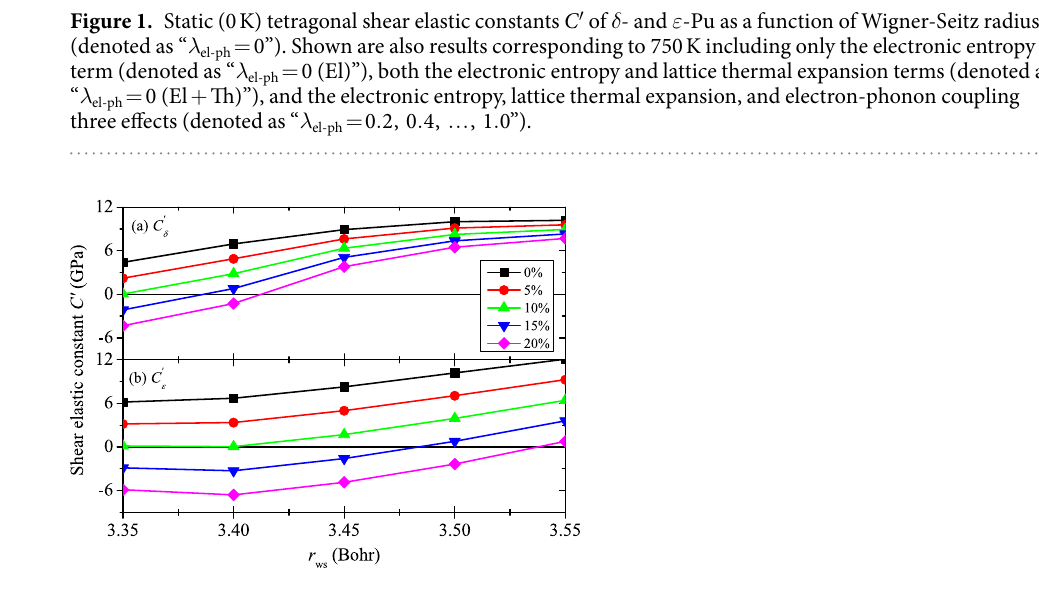
Figure 2. Tetragonal shear elastic constants C ′ of δ - and ε -Pu as a function of Wigner-Seitz radius. Results correspond to 750 K, including the electronic entropy, lattice thermal expansion, electron-phonon coupling ( λ el-ph = 1.0), and spin fluctuation effects modelled by reducing μ Pu by 0%, 5%, … , 20% relative to the static